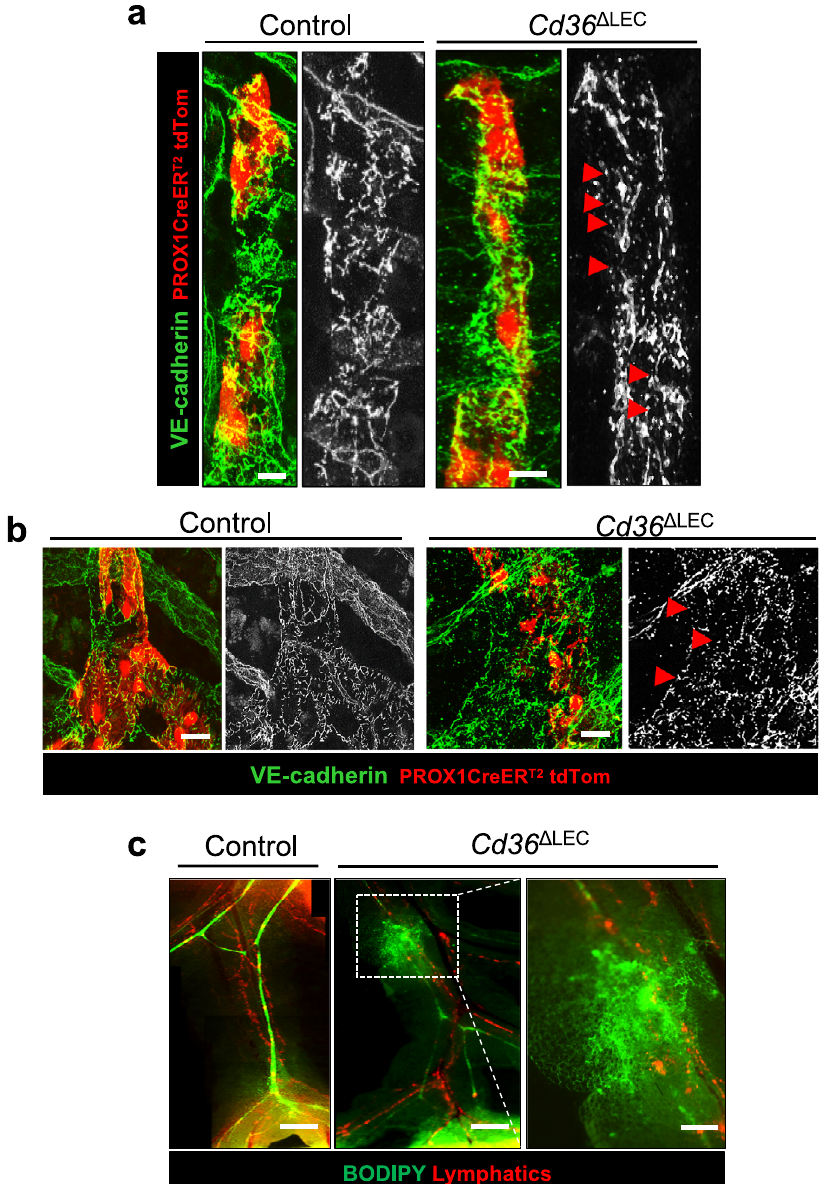
Fig. 5 Cd36 Δ LEC mice have more discontinuity of LEC VE-cadherin junctions and leaky mesenteric lymphatic vessels. Representative images of whole- mount VE-cadherin (green) immunohistochemistry in ( a ) lacteals and ( b ) submucosa collecting vessels in 20-week-old Cd36 Δ LEC and control mice ( n = 5). TdTomato (TdTom, red) identi fi es PROX1 positive cells. Images were acquired in tiled scans using a Zeiss LSM 880 Airyscan Confocal Microscope, ×40 objective. Scale bar is 5 μ m. c Fluorescent long-chain fatty acid tracer BODIPY C16 was administered intragastrically and integrity and transport function of lymphatic vessels recorded using a stereomicroscope. Scale bars: 500 μ m. Right panel shows high-magni fi cation image of the area outlined by the white dashed box (Scale bar: 200 μ m). Images are representative of two independent experiments with n representing the number of mice per